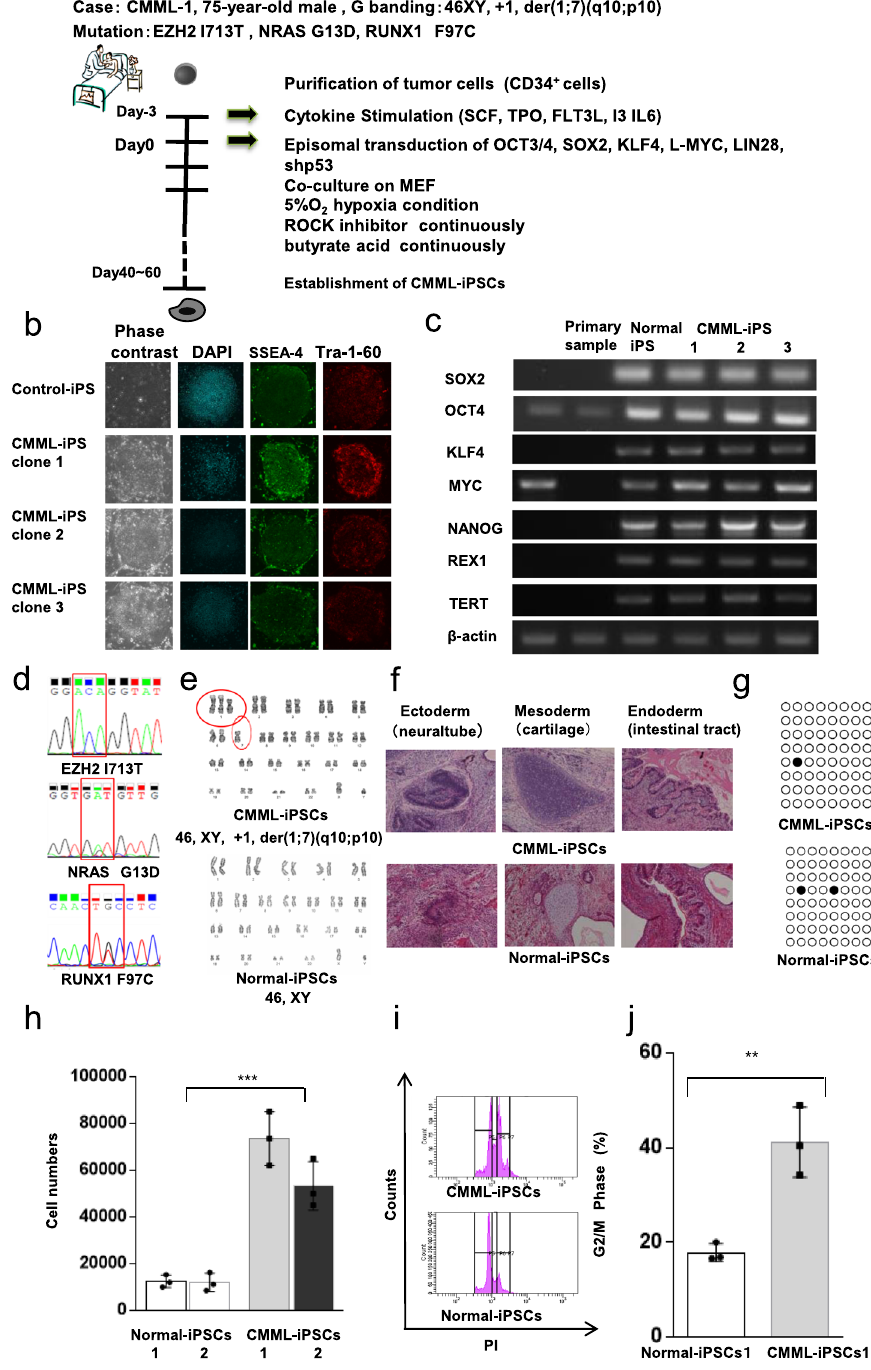
Figure 1. Generation of CMML patient-derived iPSCs. ( a ) Protocol for the generation of CMML patient- derived iPSCs. CD34 + cells from patient samples were isolated from BM mononuclear cells. OCT3/4, SOX2, KLF4, L-MYC, LIN 28, and shP53 were transduced using episomal vectors under hypoxic conditions in the presence of a Rho kinase (ROCK) inhibitor and butyrate acid. Three clones of CMML iPSCs from one patient with CMML-1 were established. ( b ) Immunofluorescence staining of pluripotency marker antigens (SSEA-4 and Tra-1-60) in Normal and CMML iPSCs. ( c ) Semi-quantitative RT-PCR of pluripotency markers. The endogenous expression of pluripotent stem cell-specific genes ( OCT3/4 , SOX2 , KLF4 , C-MYC , NANOG , REX1 , and TERT ) was confirmed. Each of the images is cropped from different gels. ( d ) EZH2 , RUNX1 , and NRAS mutations were identified in CMML iPSCs. ( e ) Representative karyotypes of CMML iPSCs showing derivative chromosome (1;7)(q10;p10), an unbalanced translocation, and Normal-iPSCs. ( f ) Histological analyses of teratomas from CMML iPSCs. A teratoma with three germ layers, the ectoderm (neural tube), mesoderm (cartilage), and endoderm (intestinal tract), was observed following H&E staining. ( g ) Bisulfite